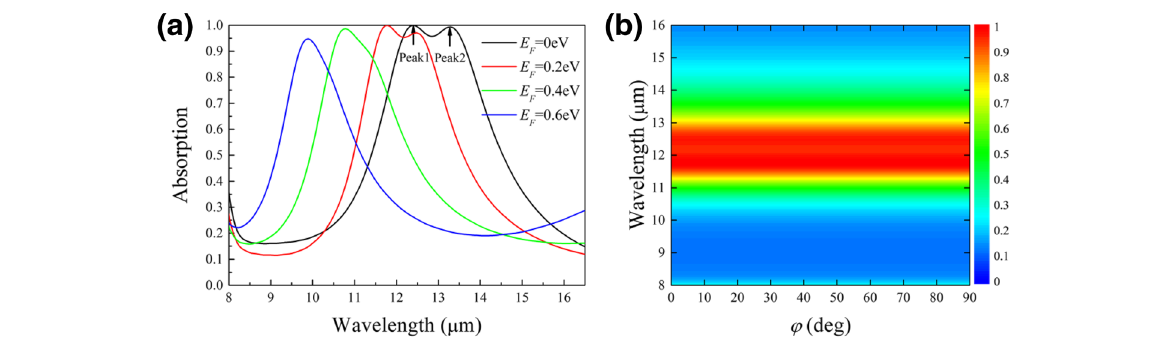
Fig. 2 Absorption spectra at the normal incidence with different E F at φ = 0, showing large blueshift of the peaks with increasing E F ( a ), and with different φ at E F = 0.2eV, demonstrating a polarization independence ( b ). The polarization angle φ is defined as in Fig.